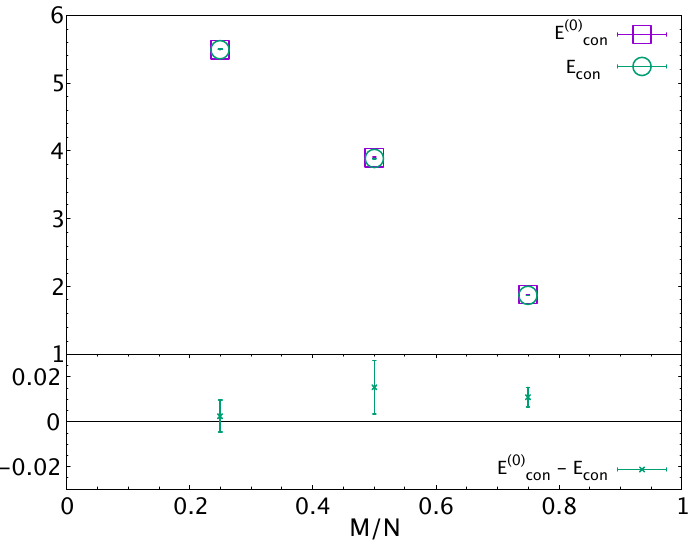
Figure 21. Yang-Mills matrix model, E con and E (0) con for N = 64 , M = 16 , 32 and 48 , with 24 lattice points. The error bars in each figure are obtained by jackknife